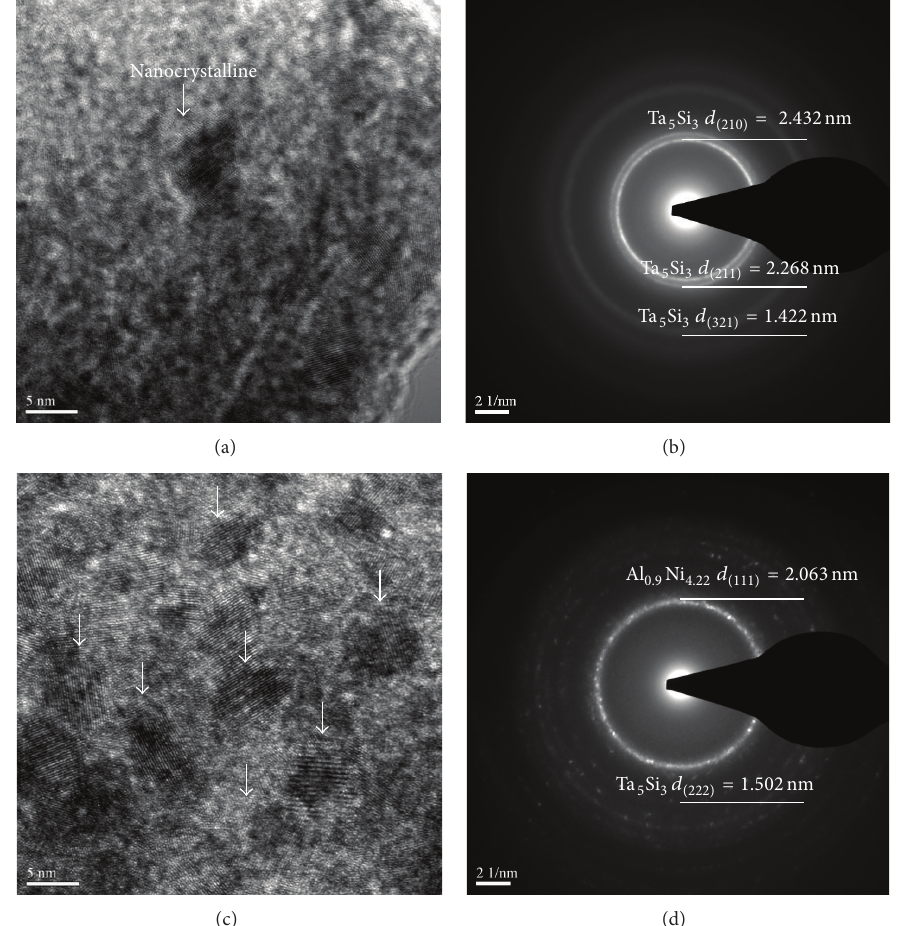
Figure 5: TEM micrographs and selected-area electron diffraction of Ni-Cr-Si-Al-Ta films sputtered and annealed at 200 W/300 ∘ C for (a) and (b) and 200 W/500 ∘ C for (c) and